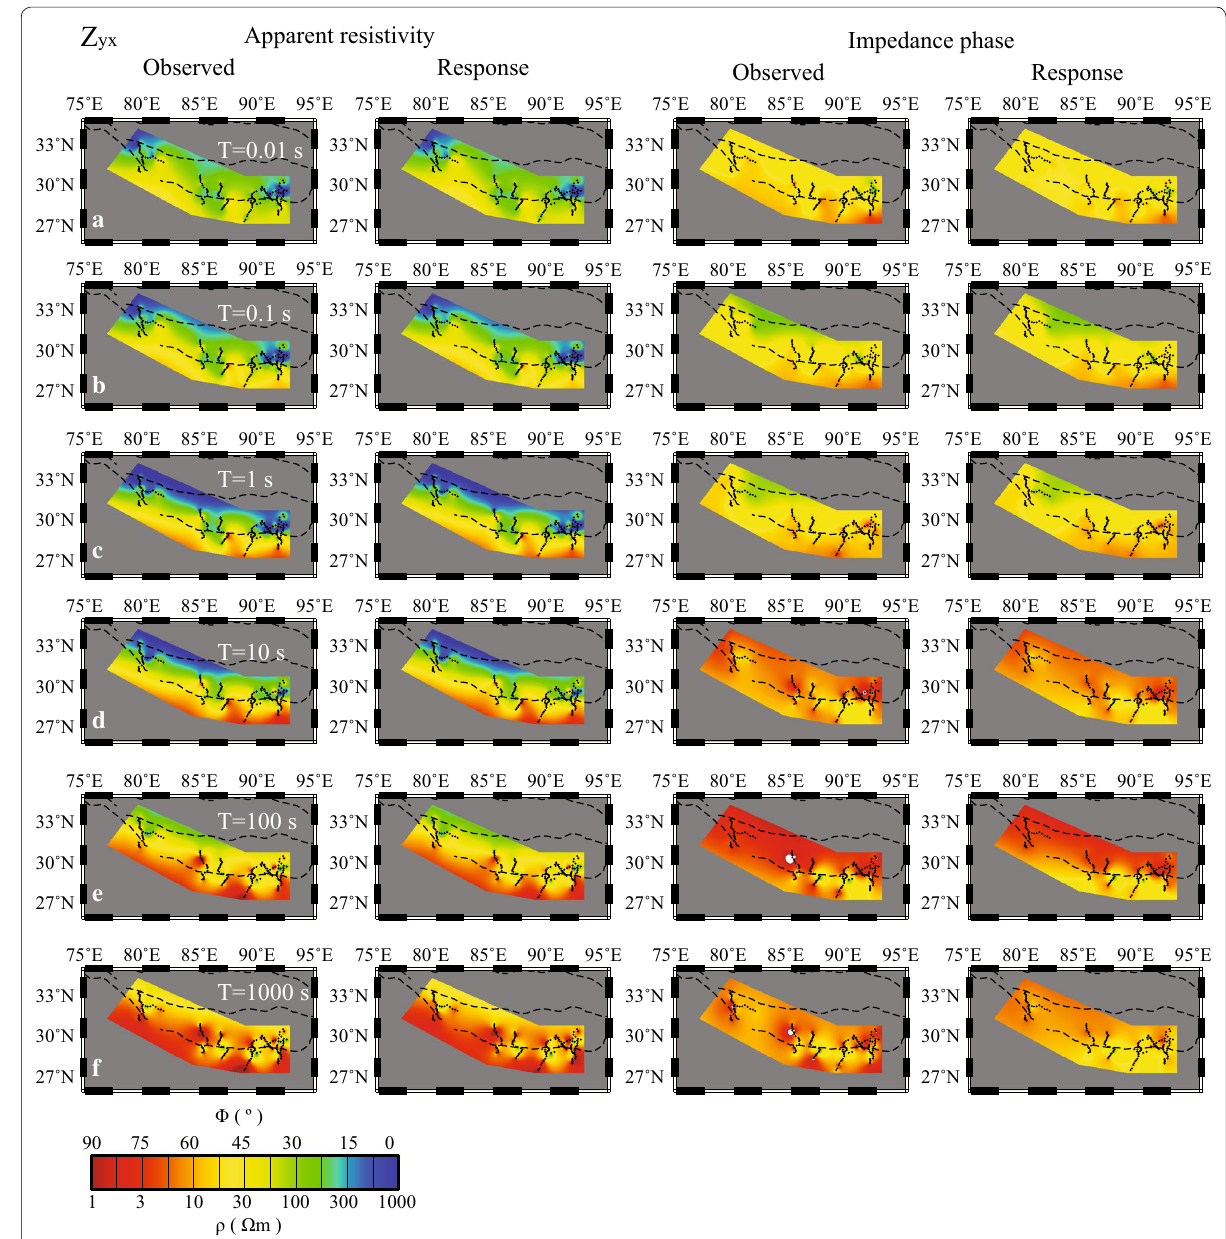
Fig. 5 Measured apparent resistivity and impedance phase and 3D model response in horizontal pseudo-slice format at different periods for Z yx . T 0.01 s ( a ), 0.1 s ( b ), 1 s ( c ), 10 s ( d ), 100 s ( e ), and 1000 s ( f =